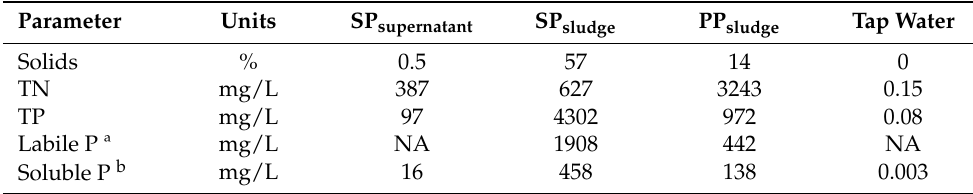
Table 2. Pond by-product nitrogen and phosphorus